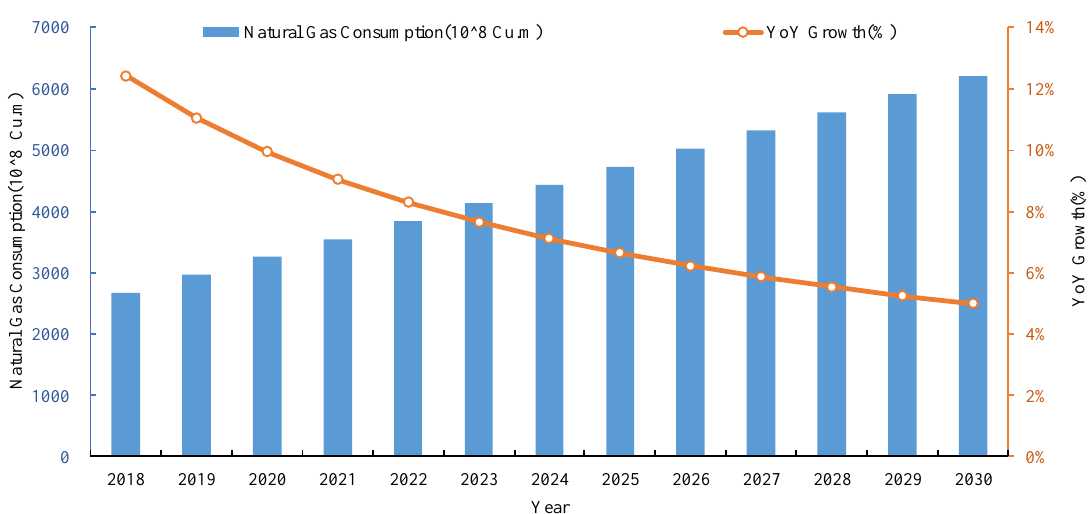
Figure 13. Trends of Natural Gas Consumption in 2018–2030.